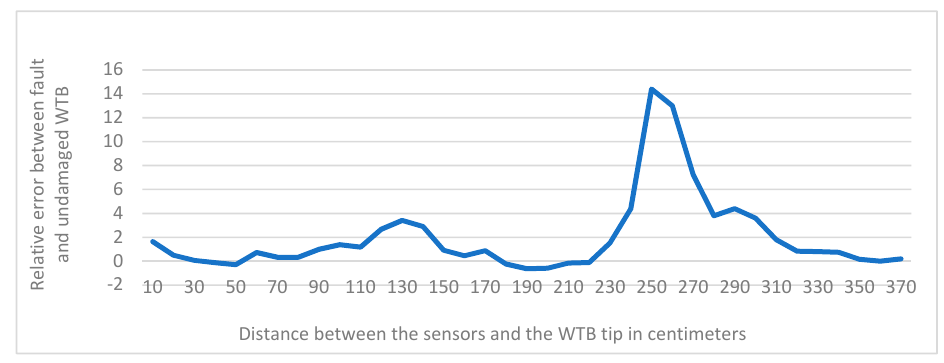
Figure 8. Relative error between damaged and undamaged WTB for each location of the sensor.